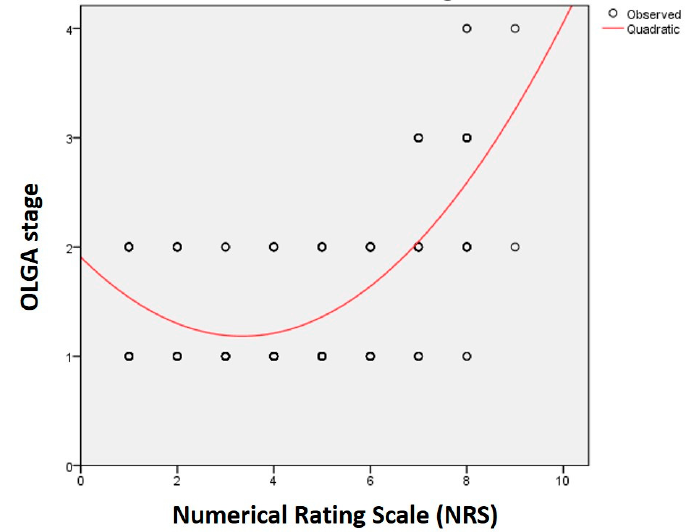
Figure 2. Curve estimations between numerical rating scale (NRS) and Operative Link for Gastritis Assessment (OLGA) stage (OLGA = 1.907 − 0.434 ∗ NRS + 0.065 ∗ NRS 2 ).